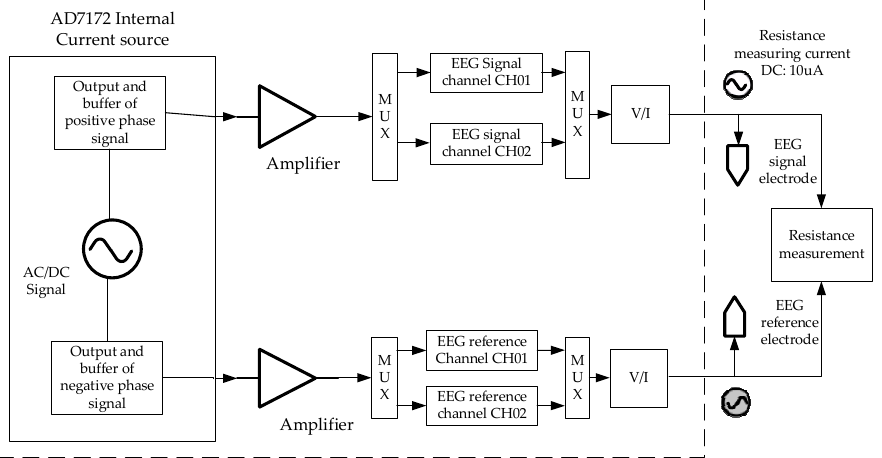
Figure 7. The functional diagram of measuring resistance.